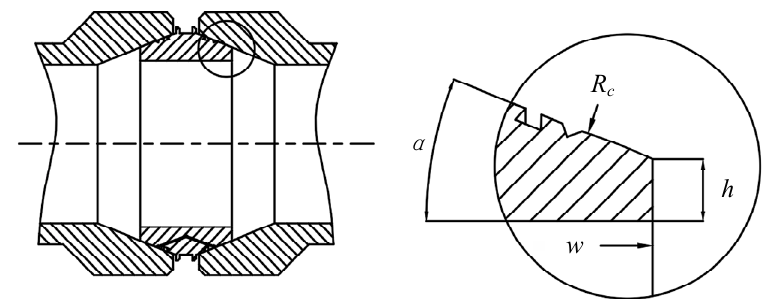
Figure 2. Key dimensions of metal sealing gasket ( α —contact angle; R c . —circular arc radius; h —edge height; w –half width).